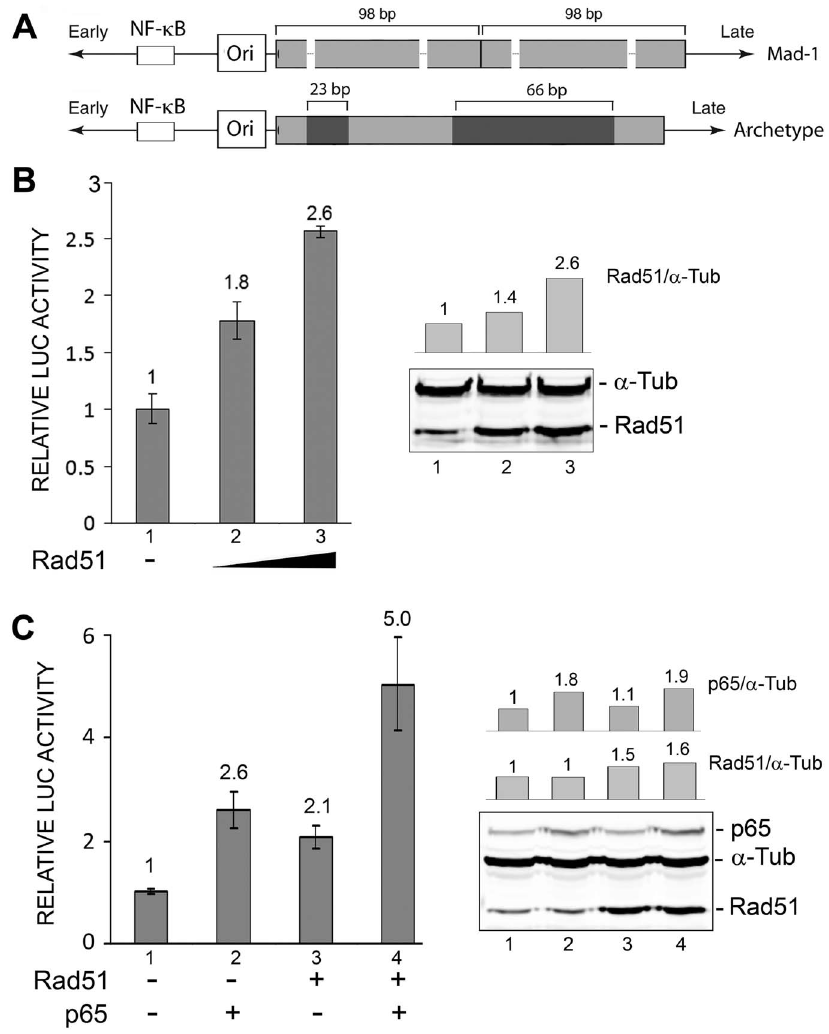
Figure 1. Effect of ectopic expression of Rad51 and NF- k B p65 on JCV early promoter reporter expression. A. Schematic representation (not to scale) of the Mad-1 neurovirulent form of JCV that was isolated from the brain of a PML patient and the archetypal form of JCV, which is found in the environment and may be the transmissible form of the virus. Relative to the archetype, Mad-1 contains 23 bp and 66 bp deletions (black boxes) in the late proximal region followed by a duplication of the remaining 98 bp sequence. Note that the NF- k B site lies in the highly conserved early proximal region of the JCV NCCR that lies between the early coding region (far left) and the viral origin of DNA replication (Ori). This region is highly conserved, not involved in rearrangements and present in all known strains of JCV. B. TC620 cells were transfected with luciferase reporter plasmid for the early promoter, JCV E -LUC in the presence or absence of increasing amounts of Rad51 expression plasmid (0, 0.5 and 1 m g). After 48 h, cells were harvested and assayed for luciferase activity. Activities were normalized to the activity for reporter alone (lane 1). The error bars represent one standard deviation. Expression of Rad51 was verified by Western blot as shown on the right-hand side of the panel with a -tubulin ( a -Tub) as a loading control. Note the lane numbering in the Western blot corresponds to the numbering in the luciferase assay histogram on the left-hand side of the panel. The intensity of the Rad51 and a -Tub bands were measured for each lane and the ratio shown as a histogram above the Western. C. TC620 cells were transfected JCV E -LUC (left) in the presence or absence of Rad1 (0.5 m g) and/or NF- k B p65 (0.5 m g) expression plasmids. Expression of Rad51 and p65 were confirmed by Western blot with a -tubulin as a loading control, and this is shown on the right-hand side of the panel. Again, the lane numbering in the Western blot corresponds to the numbering in the luciferase assay histogram on the left-hand side of the panel. The intensity of the Rad51, p65 and a -Tub bands were measured for each lane and the ratio of p65/ a -Tub and Rad51/ a -Tub are shown as histograms above the Western. described [22] using the ChIP assay kit (Upstate Cell Signaling Solutions). Cross-linking was performed with formaldehyde and the DNA sheared by sonication. The cells were lysed and immunoprecipitation was performed with antibody to Rad51, nonimmune rabbit serum or beads alone as indicated. DNA was extracted and PCR performed using primers spanning the JCV site for NF- k B that is conserved in all strains of JCV (Fig. 1A) NCCR. of JCV that cause PML including the prototypical Mad-1 strain,